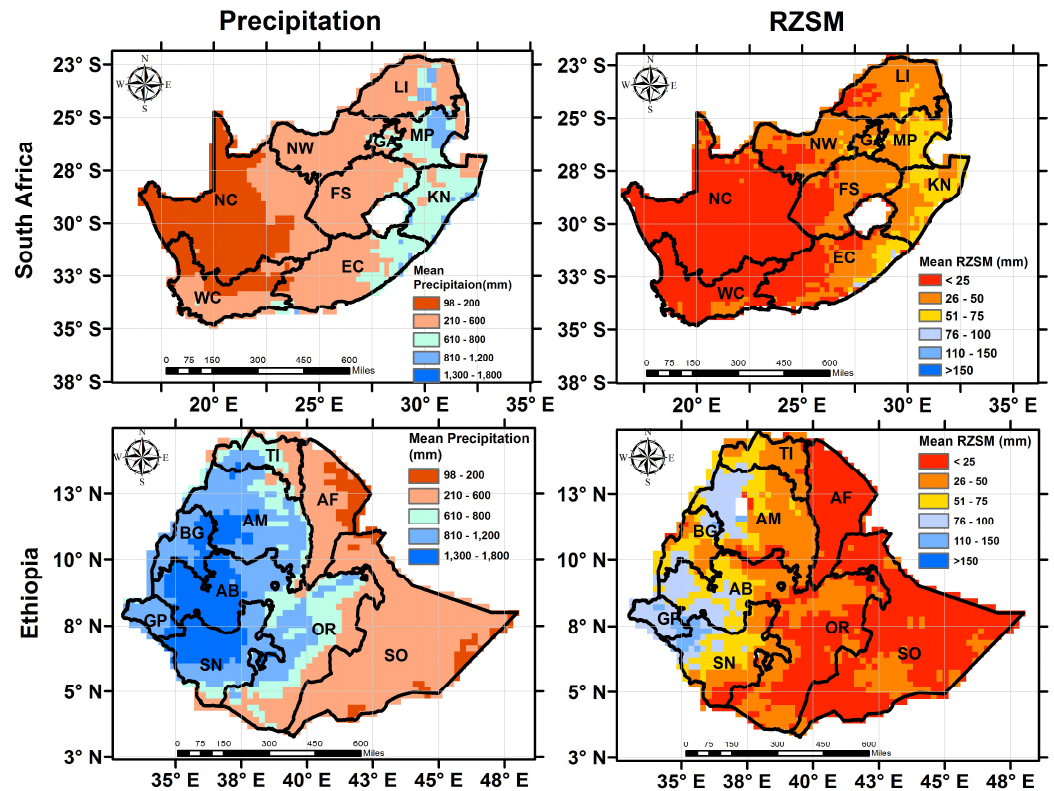
Figure 6. Spatial variability of precipitation (derived from CHIRPS precipitation data) and RZSM (derived from United States Department of Agriculture-Foreign Agricultural Services (USDA-FAS) soil moisture data) over South Africa ( top row ) and Ethiopia ( bottom row ) for the period of 2010–2017. The locations of the each province of South Africa (NC: Northern Cape, WC: Western Cape, EC: Eastern Cape, NW: North West, FS: Free State, KN: KwaZulu-Natal, MP: Mpumalanga, GA: Gauteng, and LI: Limpopo) and Ethiopia (SO: Somali, OR: Oromia, SN: Southern Nations, GP: Gambela Peoples, BG: Benshangul-Gumaz, AM: Amhara, TI: Tigray, AF: Afar, and AB: Addis Ababa) are also